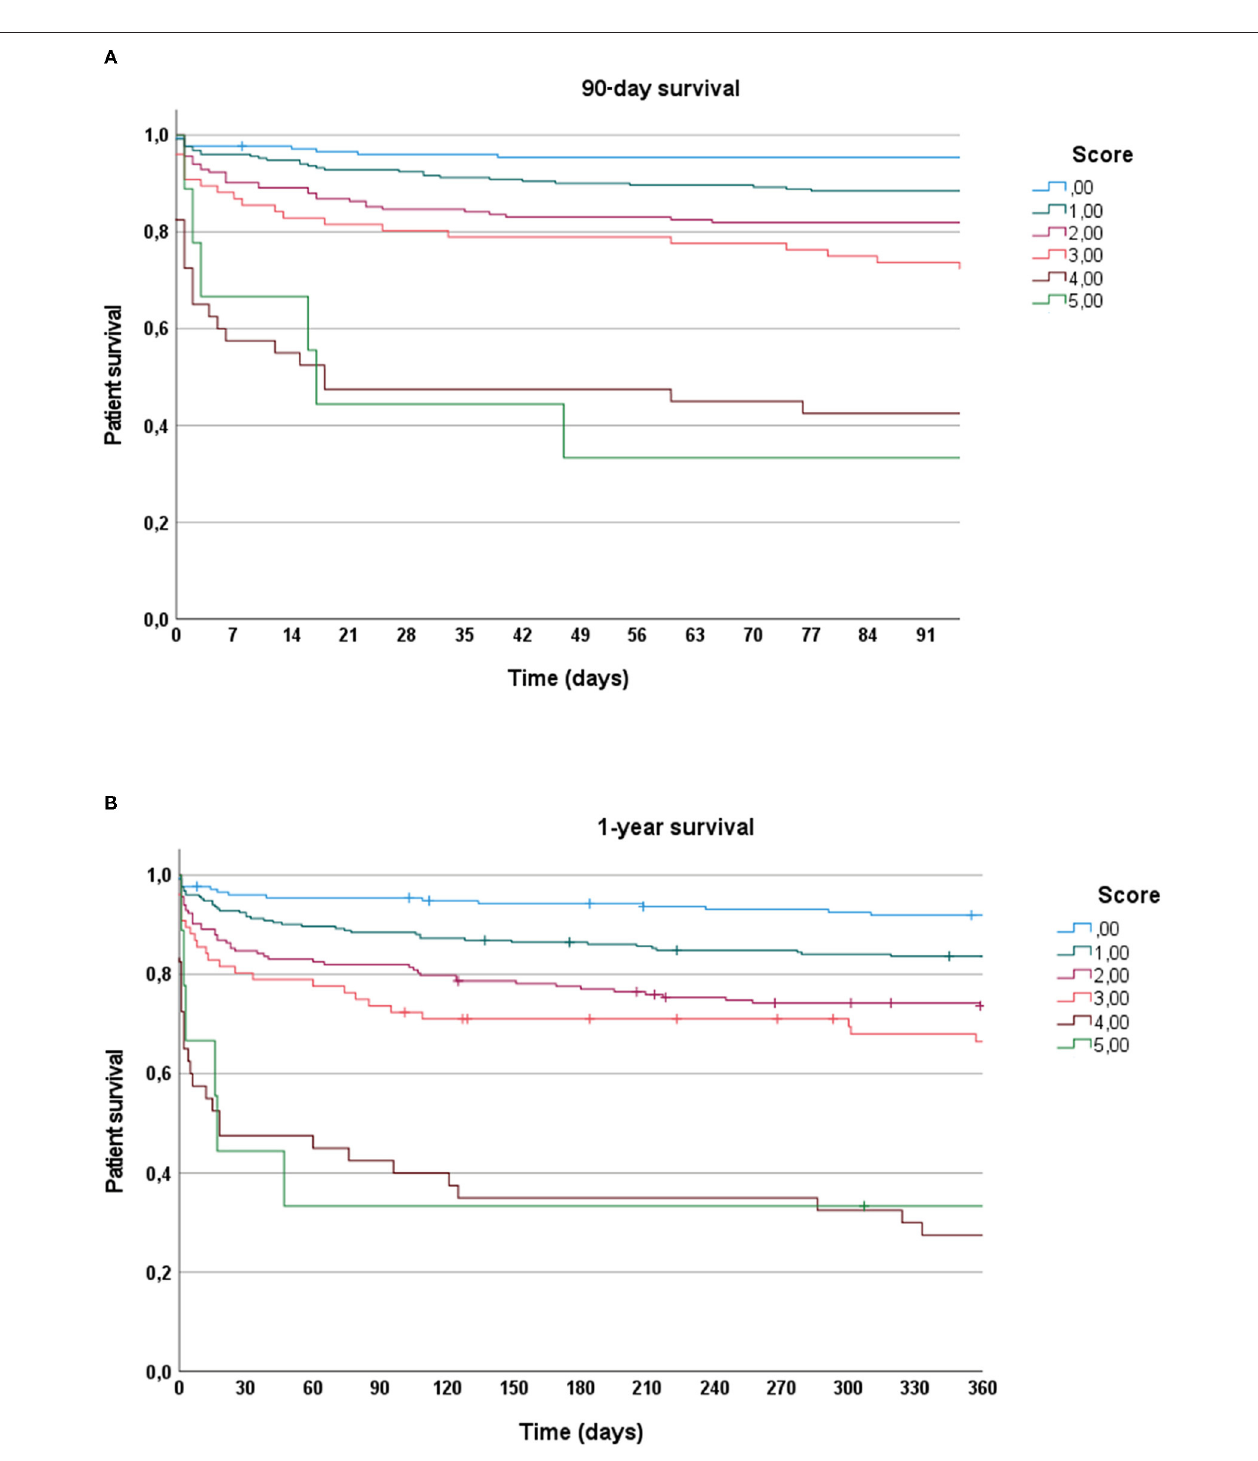
FIGURE 1 | (A) Kaplan–Meier analysis depicting 90-day survival according to Molinari score. (B) Kaplan–Meier analysis depicting 1-year survival according to Molinari score.